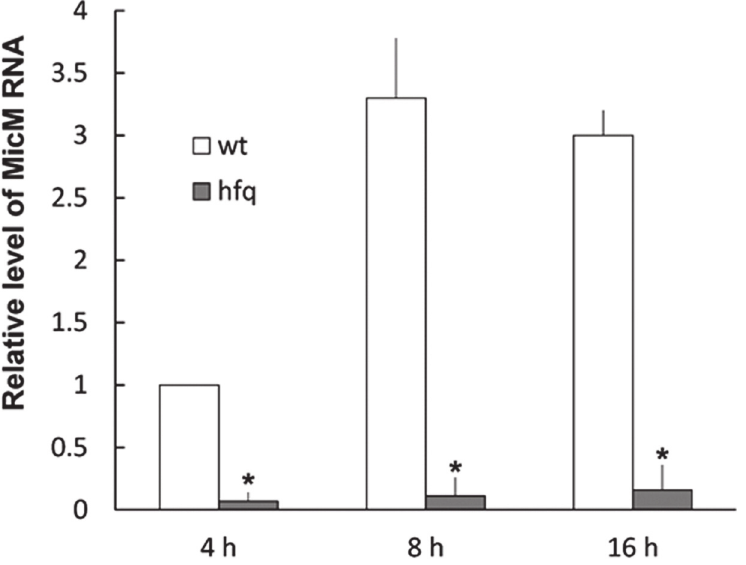
Fig 4. The expression of MicM in the wild-type and hfq mutant. The RNA amount of MicM in the wild-type or hfq mutant was quantified by real-time RT-PCR. Overnight bacterial cultures were diluted to OD 600 of 0.1 and incubated for 4 h, 8 h and 16 h before total RNA was prepared. The expression level for the wild-type cells at 4 h was set at 1. The data represent the averages of three independent experiments with standard deviations. Significant difference from the wild-type at different time point was indicated with the asterisk ( * , P < 0.01 by Student ’ s t -test analysis). wt, wild-type; hfq, hfq